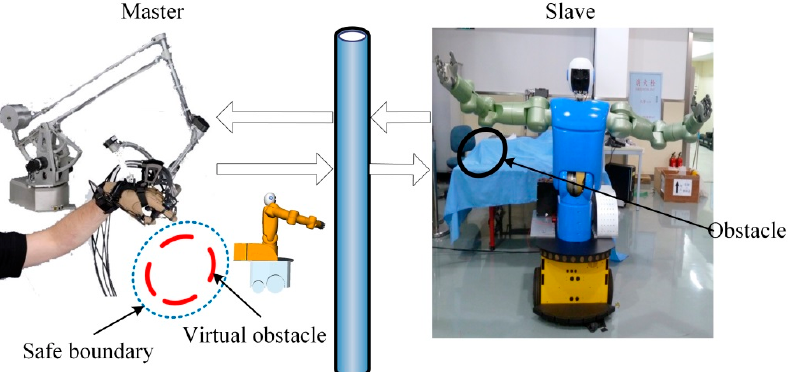
(Figure 4) at the master side is defined in Equation (4): Figure 3. Diagram of virtual impedance mapping. Figure 3. Diagram of virtual impedance mapping.